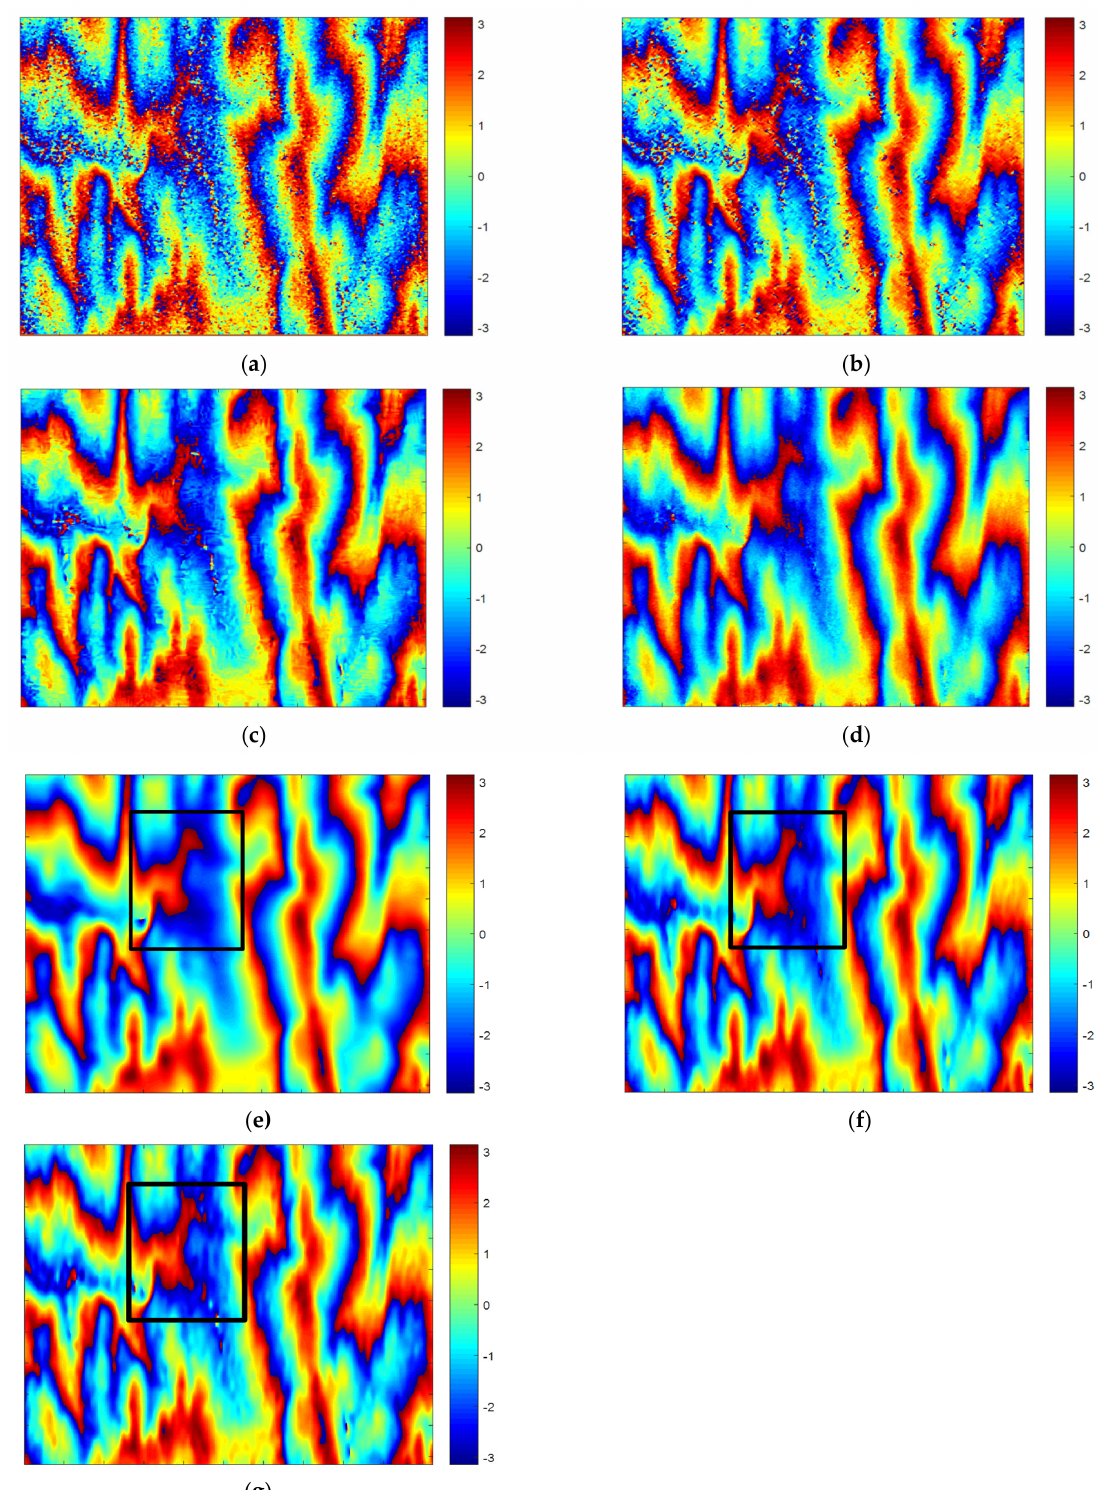
Figure 10. The filtering results obtained by processing Figure 9a using the seven methods: ( a ) filtering interferogram of the Lee filter; ( b ) filtering interferogram of the Goldstein filter; ( c ) filtering interferogram of the InSAR-BM3D filter; ( d ) the filtering interferogram of ISTA; ( e ) the filtering interferogram of Phi-Net; ( f ) the filtering interferogram of PFNet; ( g ) the filtering interferogram of the proposed method.